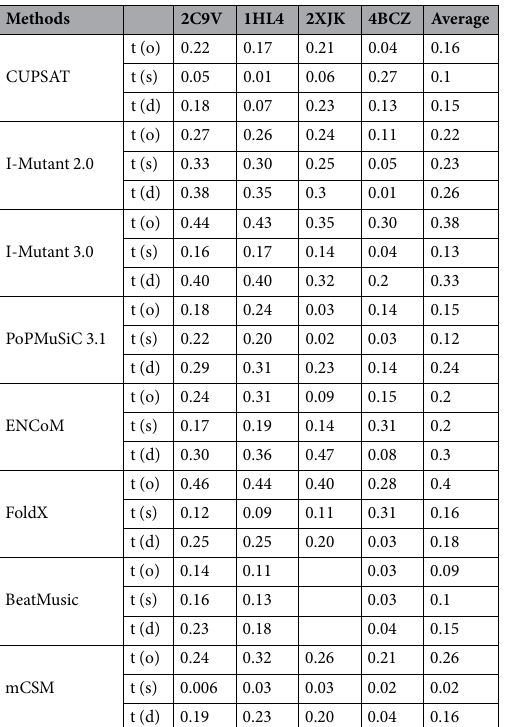
which 44 residues (loops IV and VII) are removed and substituted with short Gly-Ala-Gly linkers. The resulting apoSOD1 barrel still has its structure intact. Thus, the four structures that have been chosen resemble commonly encountered heterogeneity in high resolution structures due to missing residues, pH, and crystal space group. The structural sensitivity was evaluated by computing the average ΔΔ G obtained for a mutation across all four crystal structures, then calculating the standard deviation from this average for each residue, and finally averaging over all computed data points. Analysis of predictor performance.